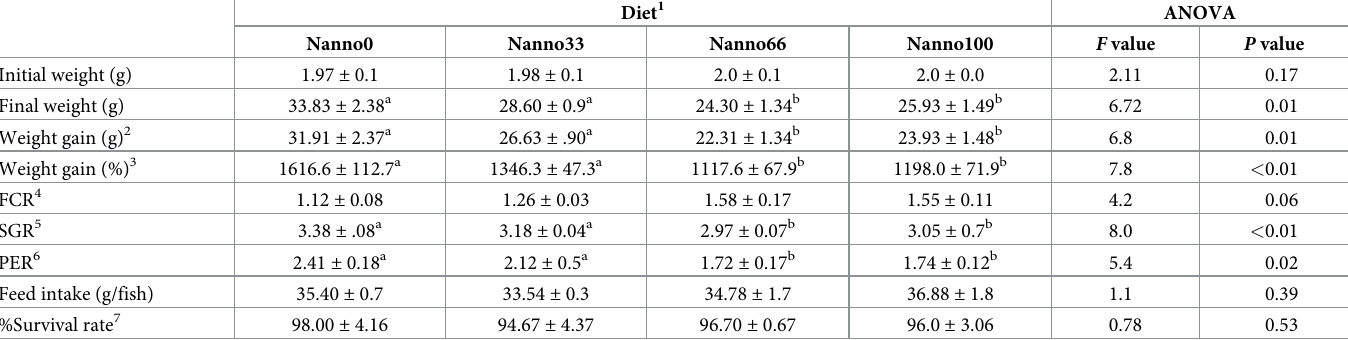
Table 11. Initial weight, final weight, weight gain, percentage weight gain, feed conversion ratio (FCR), specific growth rate (SGR), protein efficiency ratio (PER), feed intake, and survival rate of tilapia fed experimental